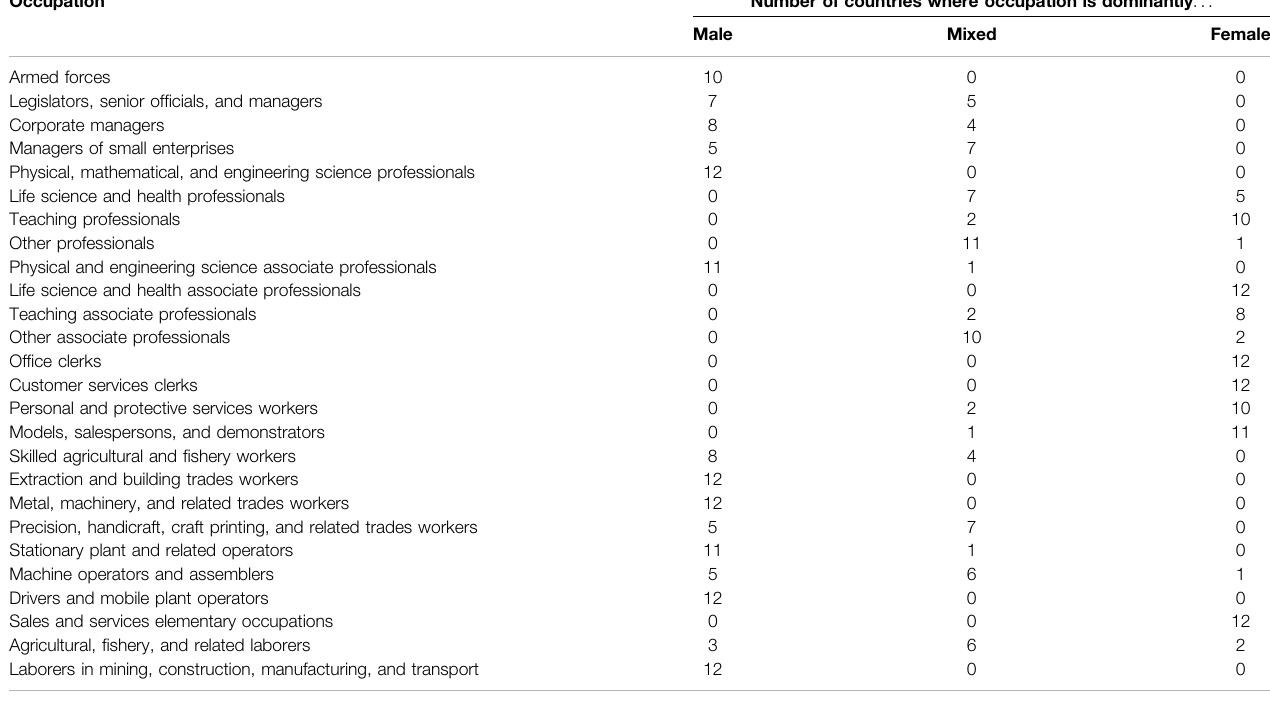
TABLE 1 | Gender occupation stereotypes (Bettio and Verashchagina 2009). Occupation Number of countries where occupation is dominantly